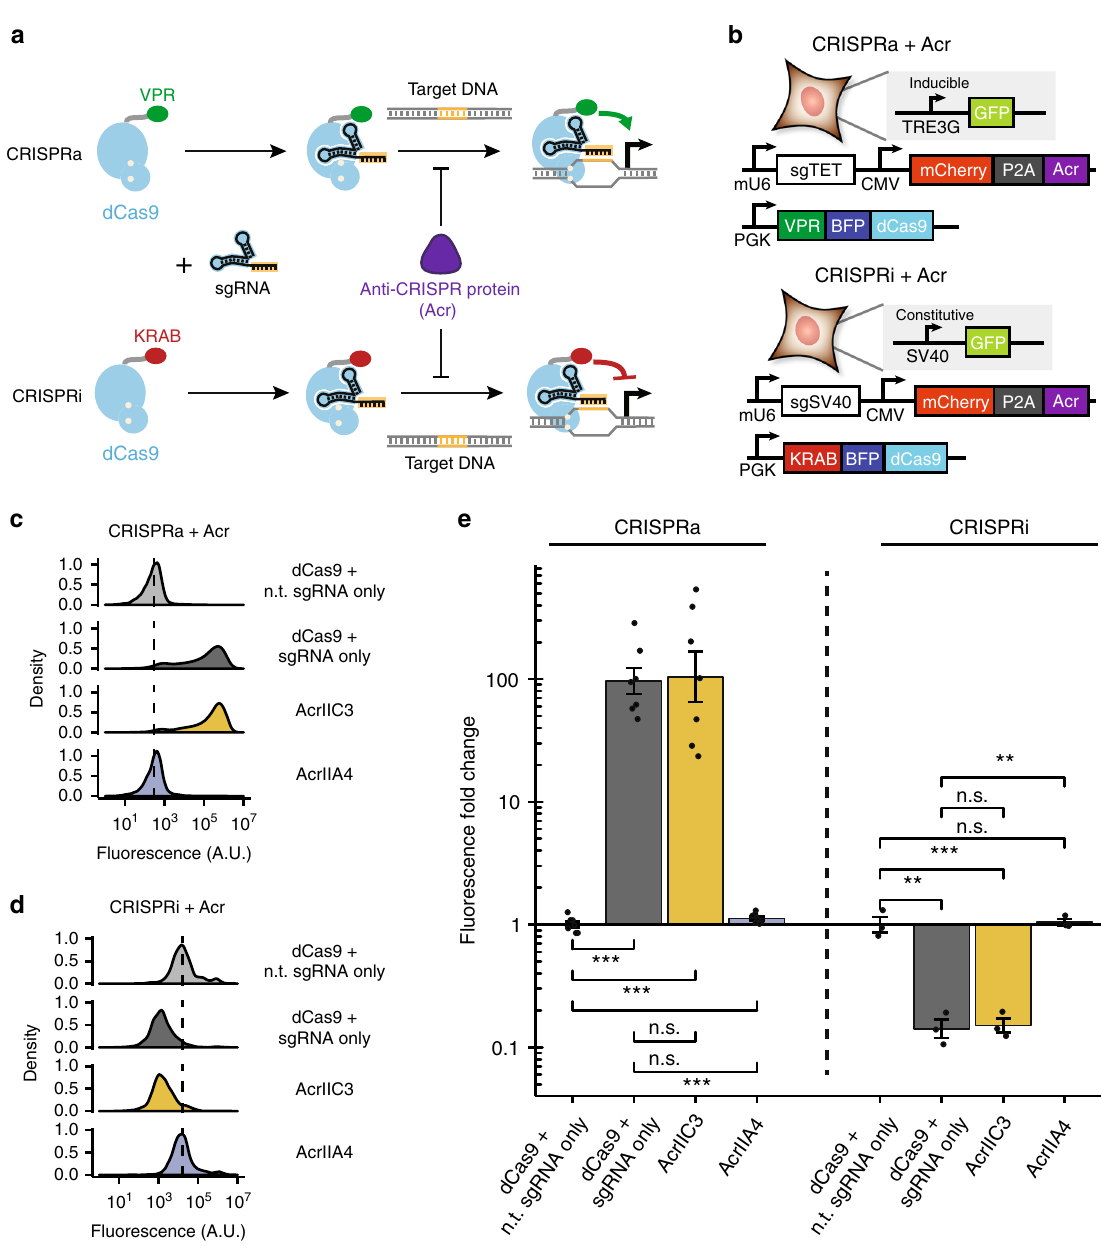
Fig. 1 CRISPR-based gene regulation provides quantitative characterization of Acr activity. a Gene regulation mediated by sgRNA-programmed binding of dCas9 fused with gene activation domain VPR (CRISPRa) and gene repression domain KRAB (CRISPRi). Acrs that inhibit binding of DNA should prevent CRISPRa and CRISPRi. b Box diagrams for experimental assay of Acr activity: cell lines with integrated reporter for CRISPRa (top) and CRISPRi (bottom) are transiently transfected with plasmids encoding appropriate dCas9 effector, sgRNA, and Acr variants fused via P2A peptide to mCherry. c , d Representative raw fl uorescence fl ow cytometry traces for CRISPRa ( c ) and CRISPRi ( d ) assays. Negative control (dCas9 effector + non-targeting [n.t.] sgRNA) and positive control (dCas9 effector + active sgRNA) conditions in absence of Acr are compared to conditions with AcrIIC3 or AcrIIA4 incorporated in active sgRNA plasmid. Dotted line indicates median value of non-targeting sgRNA negative control. e Summary comparison of CRISPRa and CRISPRi activity in presence and absence of active and null Acrs (n.s.: p > 0.05; **: p < 0.01; ***: p < 0.001) for n = 7 (CRISPRa) and n = 3 (CRISPRi) experimental replicates. Source Data are provided as a Source Data fi le. Error bars indicate ±